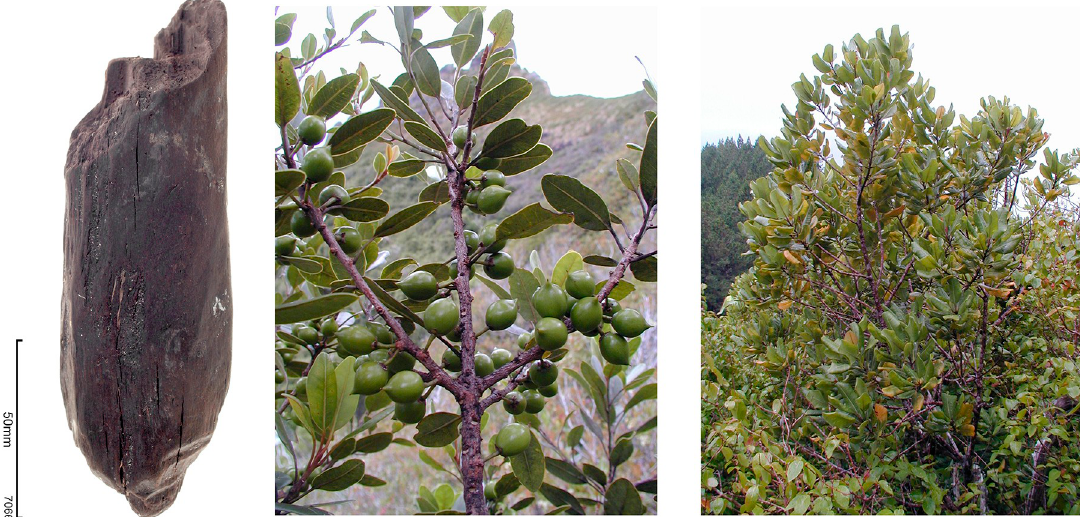
Fig 10. Left: archaeological specimen of Sideroxylon sp. from Layer IV, Trench 1; note cuts at lower end. (Photo by Tim Mackrell); Centre: Sideroxylon polynesicum in fruit, Mount Taga, Rapa Island, 2002. (Photo courtesy of Jean-Yves Meyer); Right: mature Sideroxylon polynesicum , Matotea, Raivavae Island, 2002. (Photo courtesy of Jean-Yves